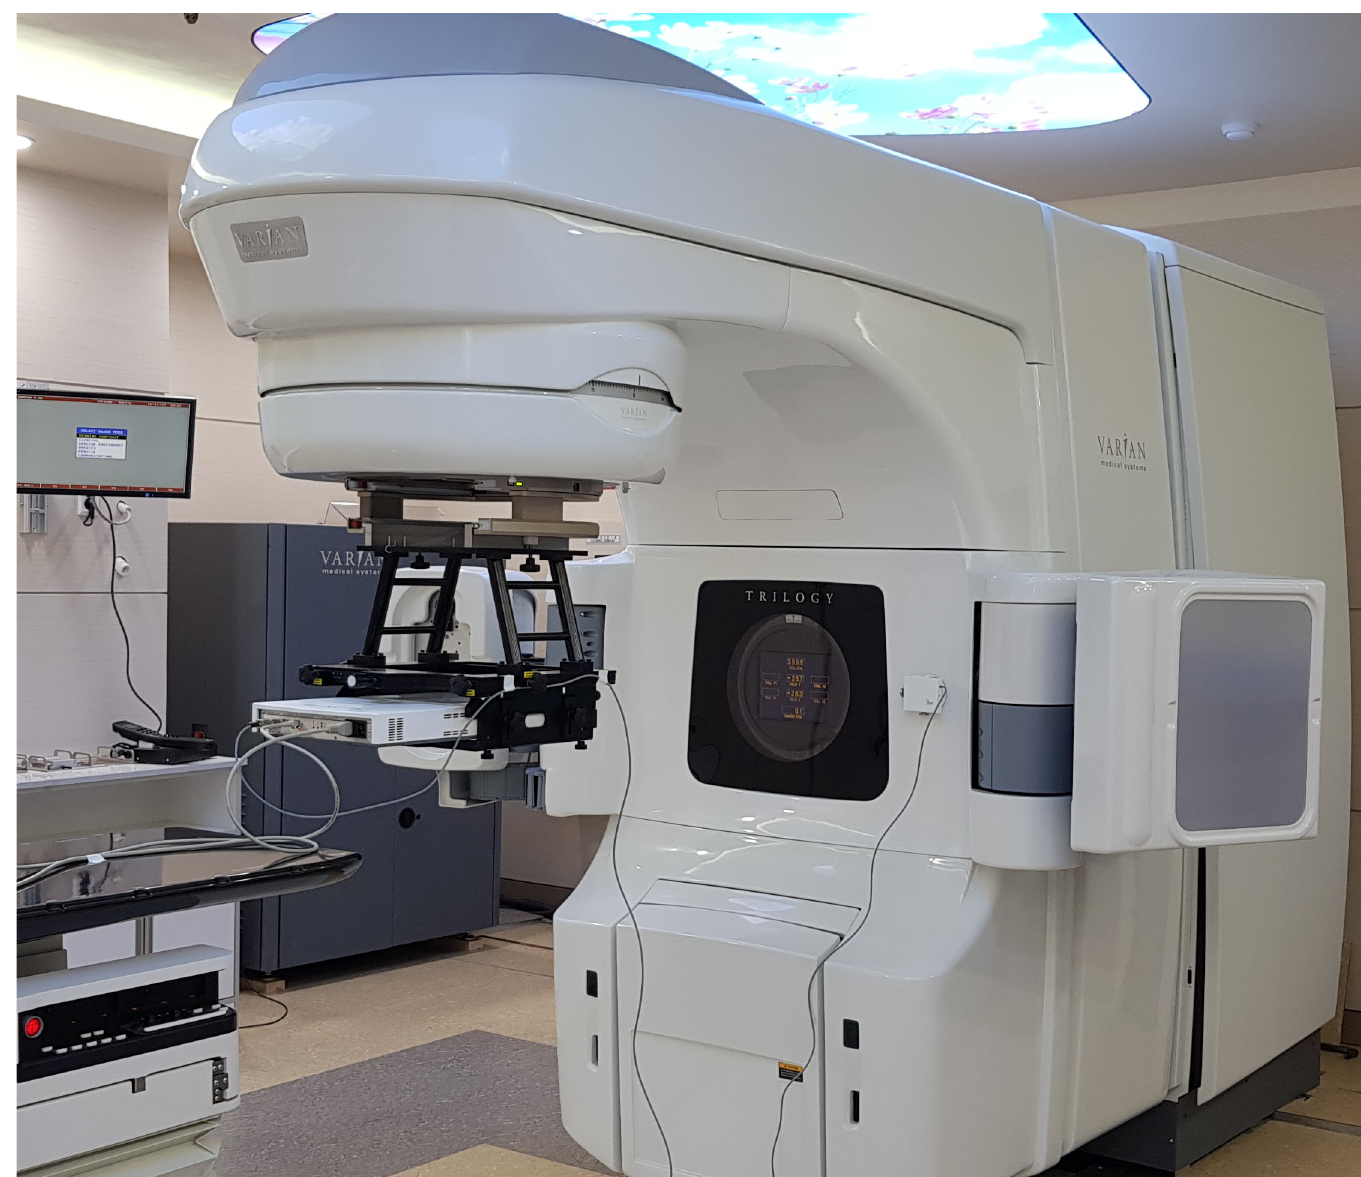
Fig 3. Dose measurement with MatriXX through the actual beam delivery of each